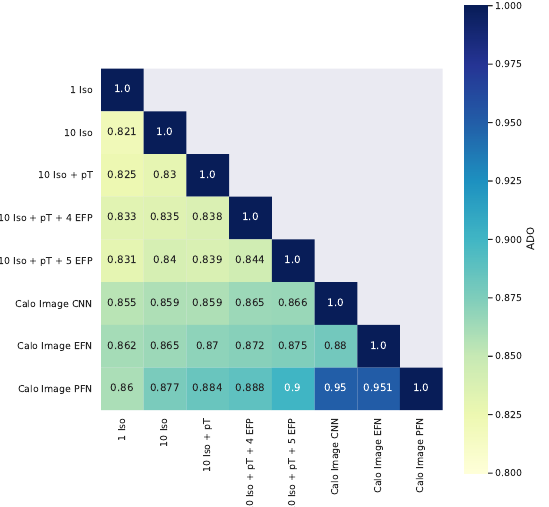
Figure 7. Comparison of the similarity of decisions made by pairs of networks, as quantified by the Average Decision Ordering (ADO) [22], defined in the